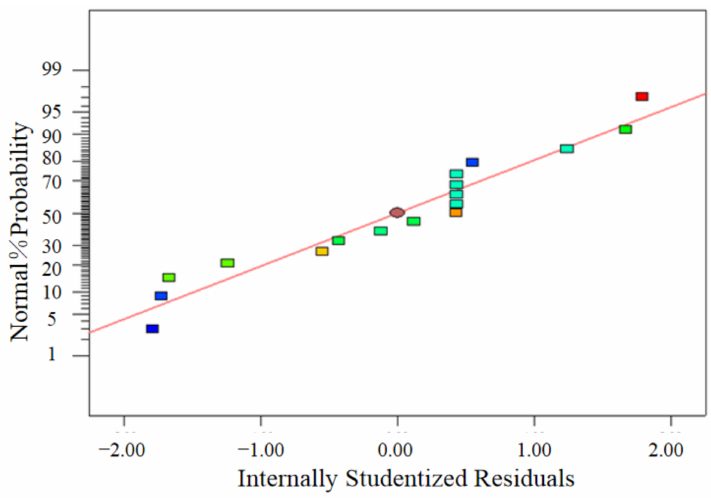
Figure 10. Comparison between predicted and actual values of different factors.